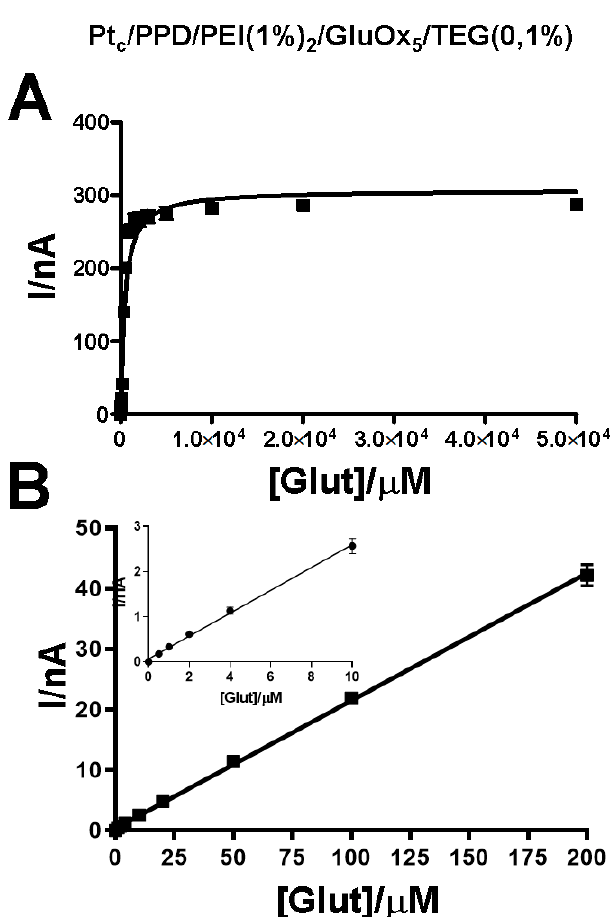
Figure 2. Representative plot of biosensor loading TEG (0.1%) calibrations. The non-linear fitting of data ( Panel A ) was performed in the range 0–5 × 10 4 µ M of concentrations of glutamate. Meanwhile, the linear fitting of data ( Panel B ) was made in the 0–200 µ M range In the inset of Panel B , linear regression data obtained from 0–10 µ M range of concentrations of glutamate is highlighted. Data were obtained from Day 1